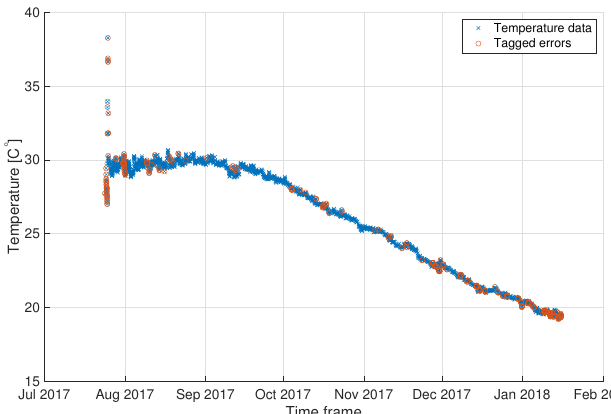
Figure 3. A time-series (blue) of the surface water temperature recorded by THEMO over the selected time frame (the examined dataset), with the anomalies tagged by an expert marked (red).